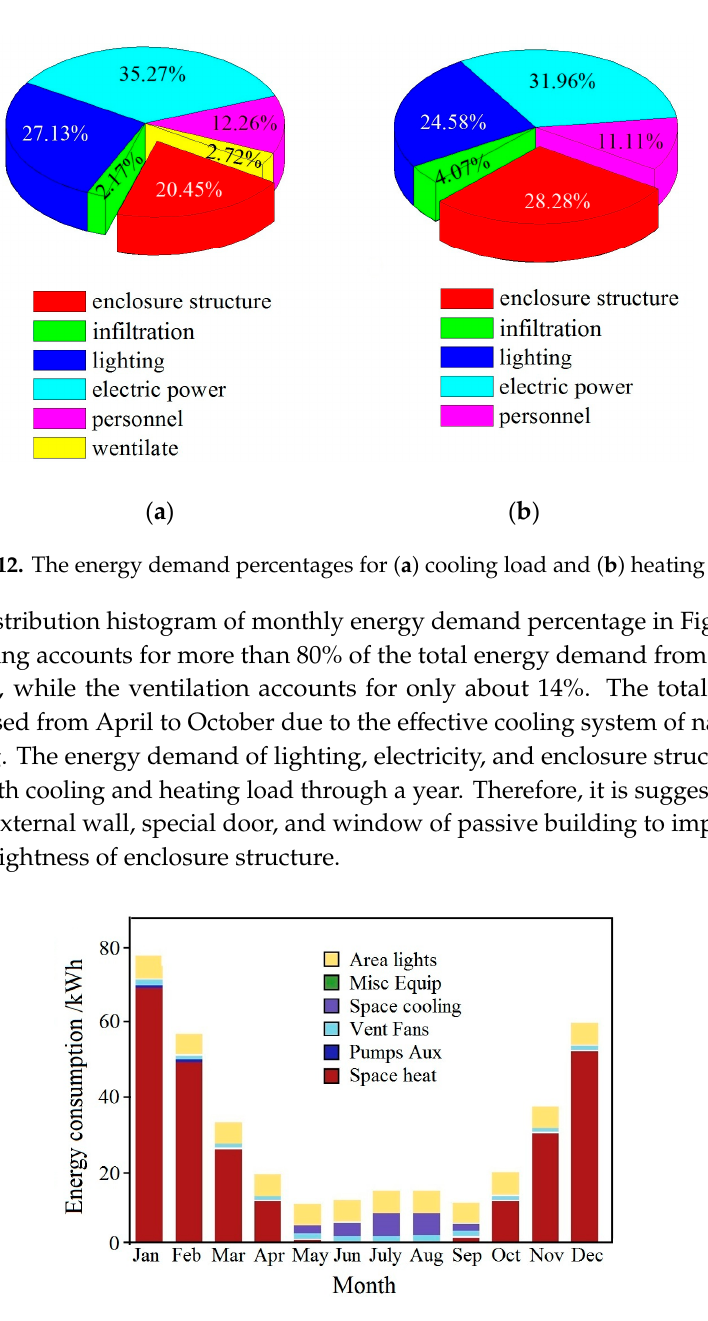
Figure 13. Total energy demand monthly through a year.